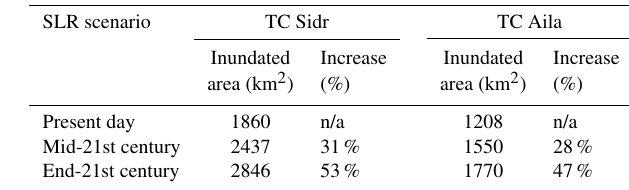
Table 5. Comparison of the inundated area between present-day and future SLR scenarios and calculated change in percentage with re- spect to the present-day